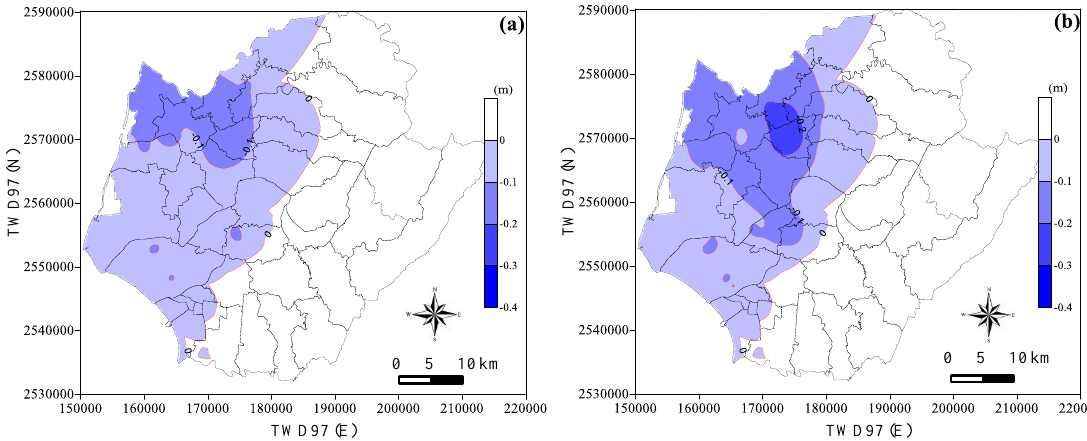
Figure 7. Subsidence distribution in Tainan predicted using combination of the NPM and GSM for the target years (a) 2020 and (b) 2039 (From Wang et al.,